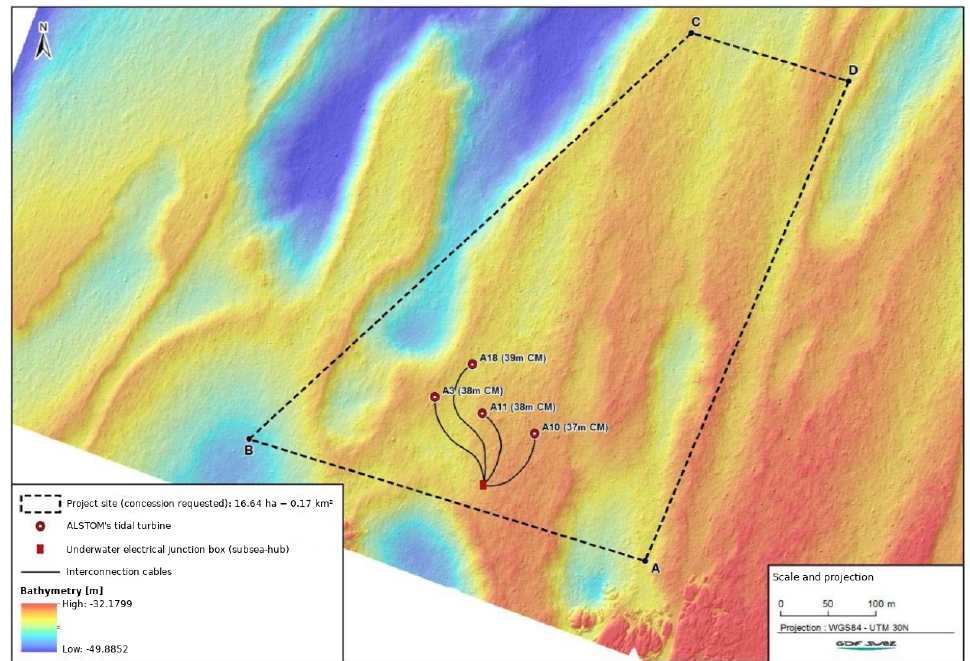
Figure 1. Configuration of the NEPTHYD project: a four turbine precommercial farm developed by Engie in 2014 and supposed to be equipped with Alstom’s Oceade™ turbine. The image is reproduced and adapted from the report [36] of the Autorité Environnementale, an agency of the French Ministry of Energy and